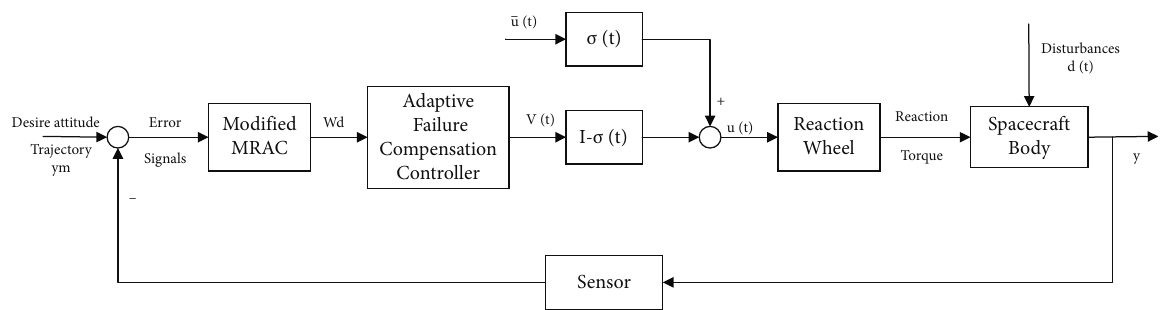
Figure 1: Block diagram of control